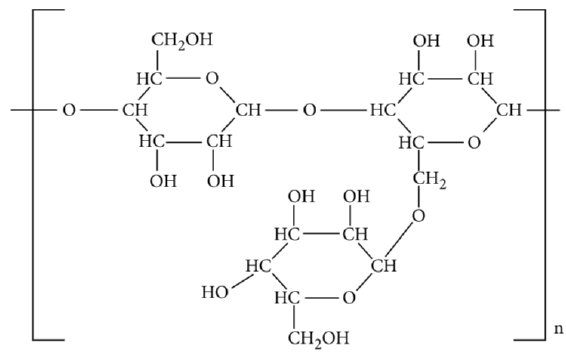
Figure 2. Molecular Structure of guar gum [41] .